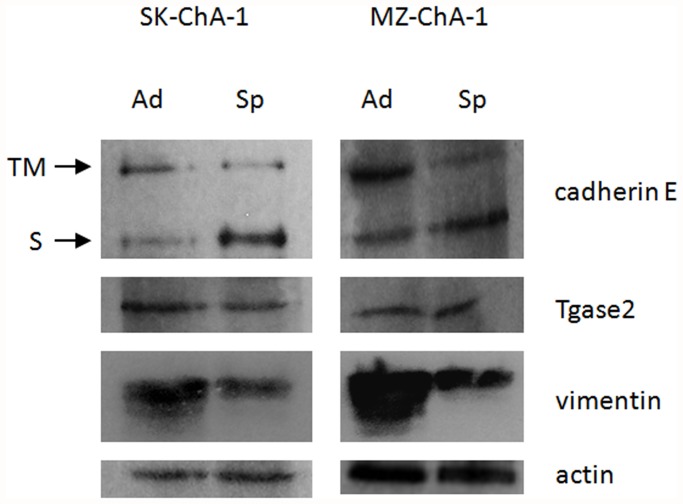
Western blot analysis in adherent and spheroid cells.The figure presents a representative experiment obtained with SK-ChA-1. Ad: adherent; Sp: spheroid; TM: trans-membrane form of cadherin E; S: soluble form of cadherin E.